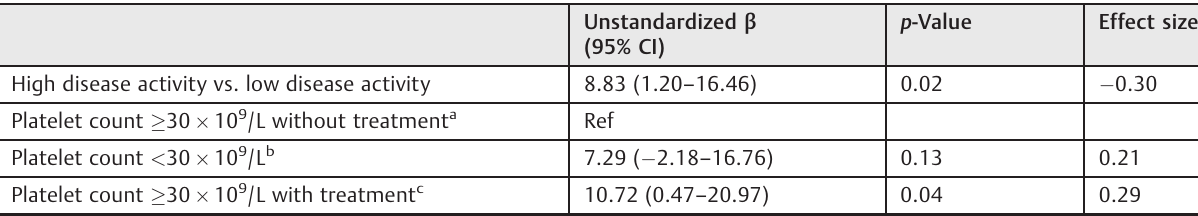
Unstandardized β p -Value Effect size